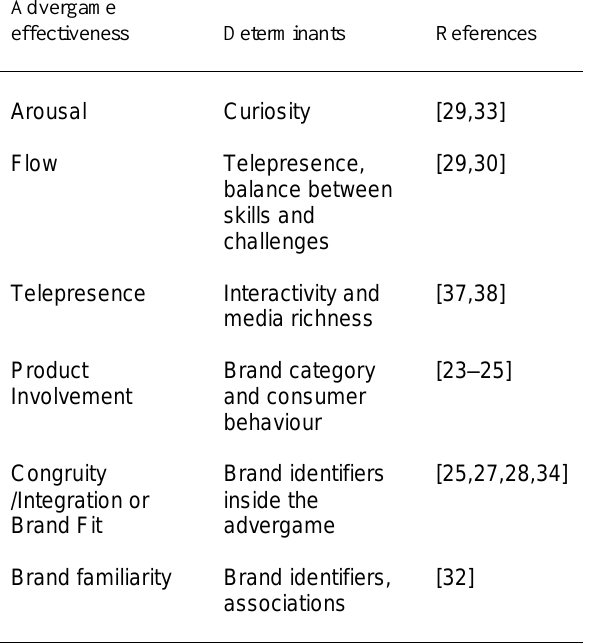
Table 2 Determinants of advergame effectiveness according to the